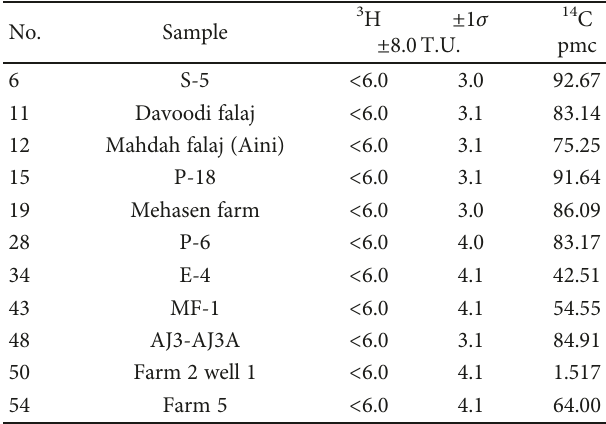
Table 3: Tritium and percentage of modern carbon results for selected groundwater